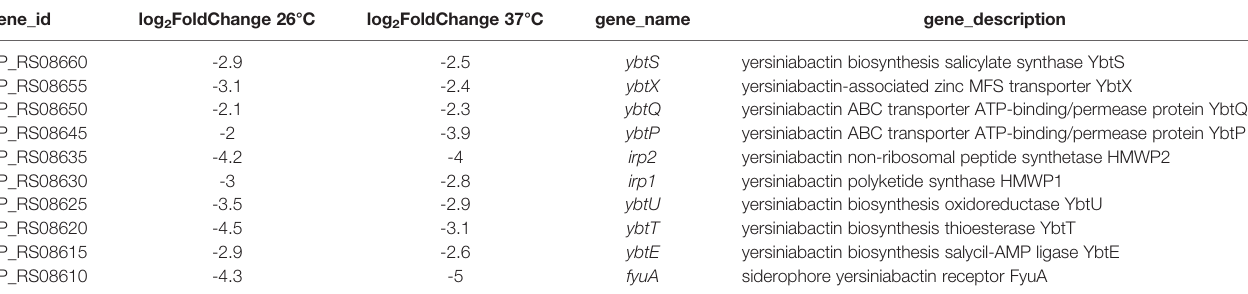
TABLE 2 | The genes of Ybt system were down-regulated in D fyuA GCAdel in comparison with 201-WT. gene_id log 2 FoldChange 26°C log 2 FoldChange 37°C gene_name